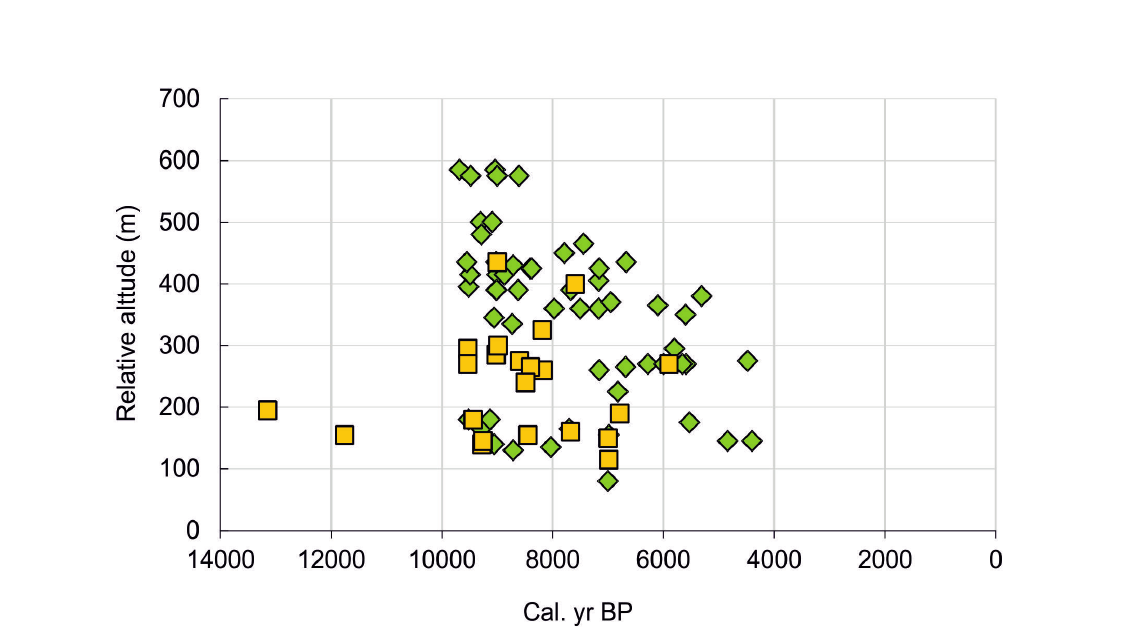
Figure 42: Composite sample of all radiocarbon-dated megafossil birches (green) and pines (yellow), relative to the present position of the birch treeline. Helags/Sylarna, Tärna and Abisko